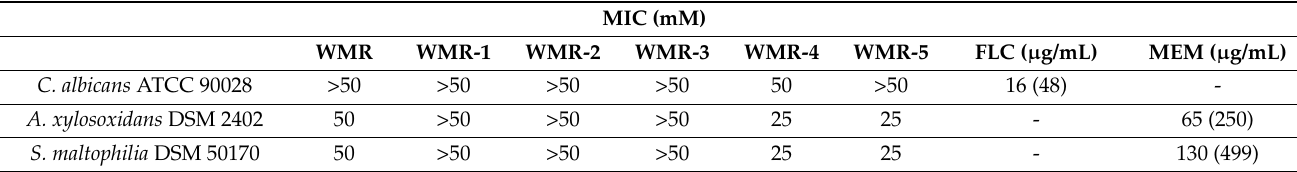
Table 3. Minimal inhibitory concentration (MIC) of WMR analogues, FLC, and MEM against species used in our